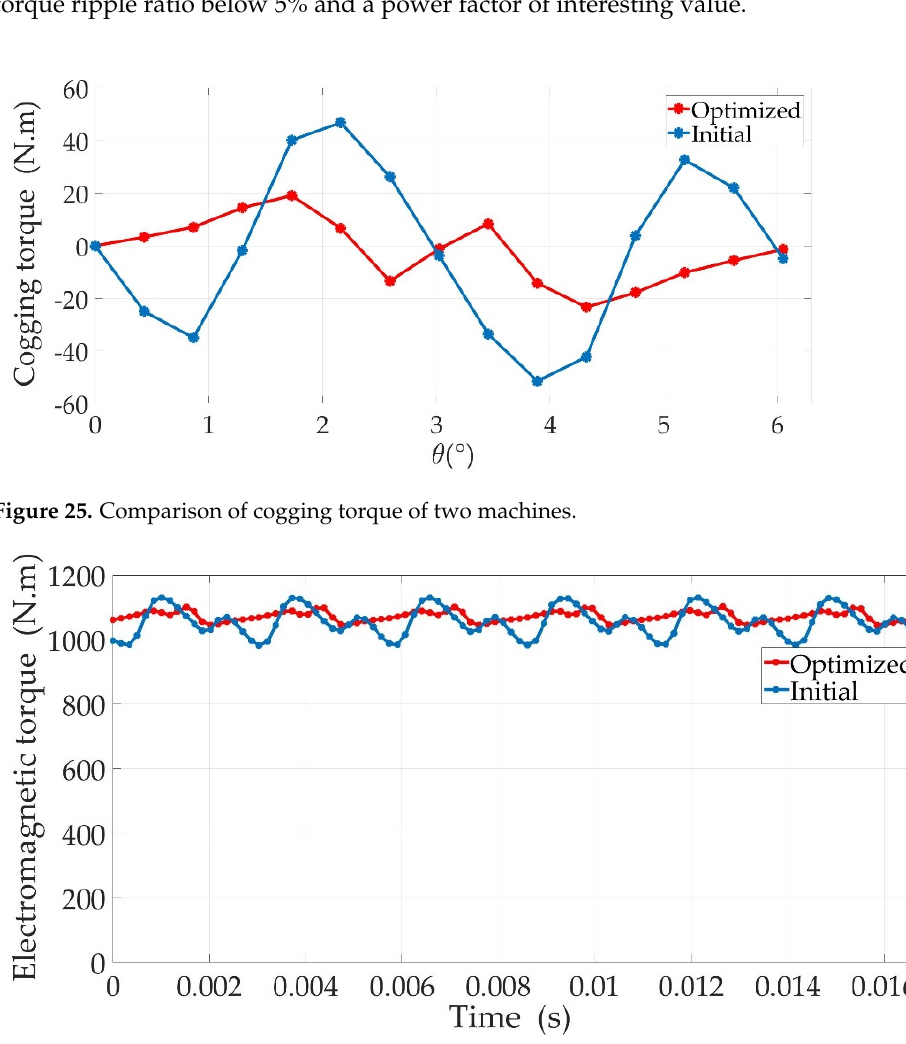
Figure 26. Comparison of electromagnetic torque of two machines.